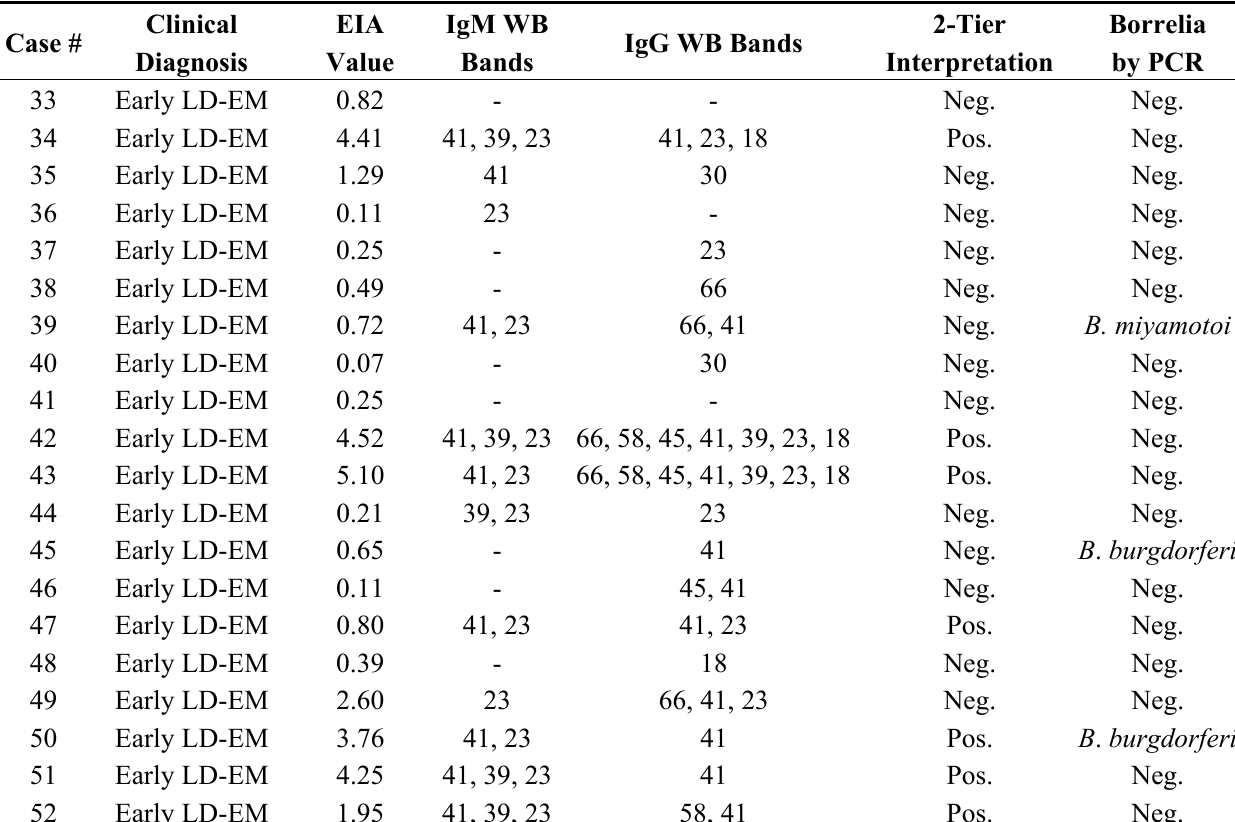
Table 2. Results of 2-tier serology test and PCR detection of borrelia in split serum samples from pre-treatment Lyme Disease